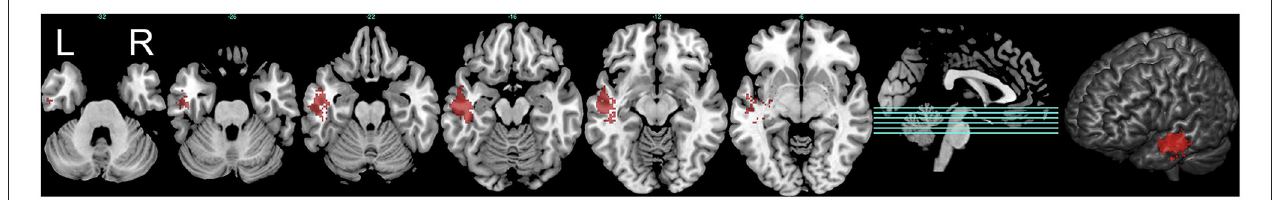
FIGURE 4 | The predilection region of proneural subtype defined by VLSM analysis. The VLSM analysis determined the predilection regions of proneural subtype in the left inferior temporal medulla (marked in red). Three-dimensional render of the VLSM-determined area was also illustrated. L represented left side, and R represented right side. This figure only showed the result below an FDR-adjusted threshold ( P < 0.05).